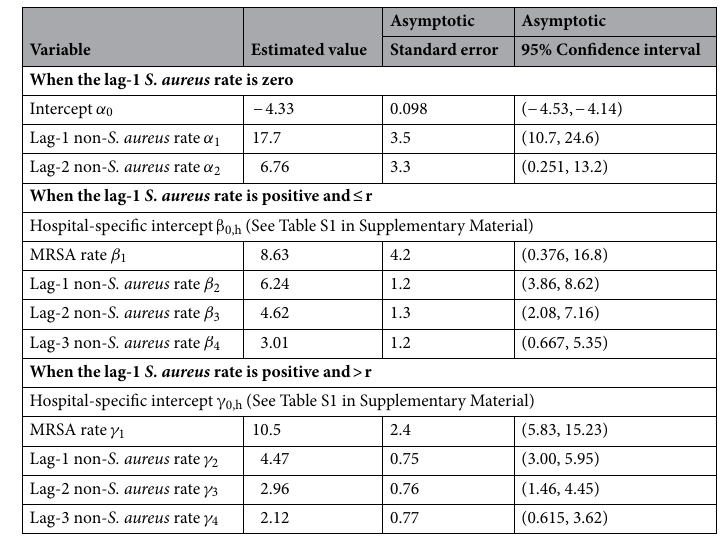
Table 1. Maximum likelihood estimates of the parameters in the fitted threshold